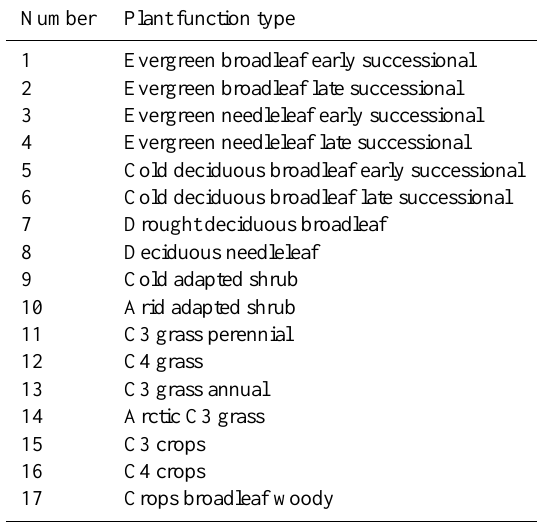
Table 1. Plant functional types in